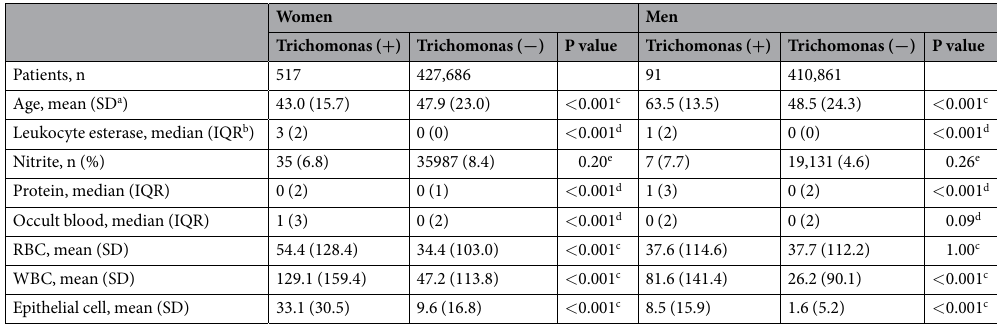
Table 1. Demographic Characteristics and Urinalysis Results of Individuals with Trichomonas vaginalis - Positive and Trichomonas vaginalis -Negative Specimens. a SD: Standard deviation; b IQR: Interquartile range;